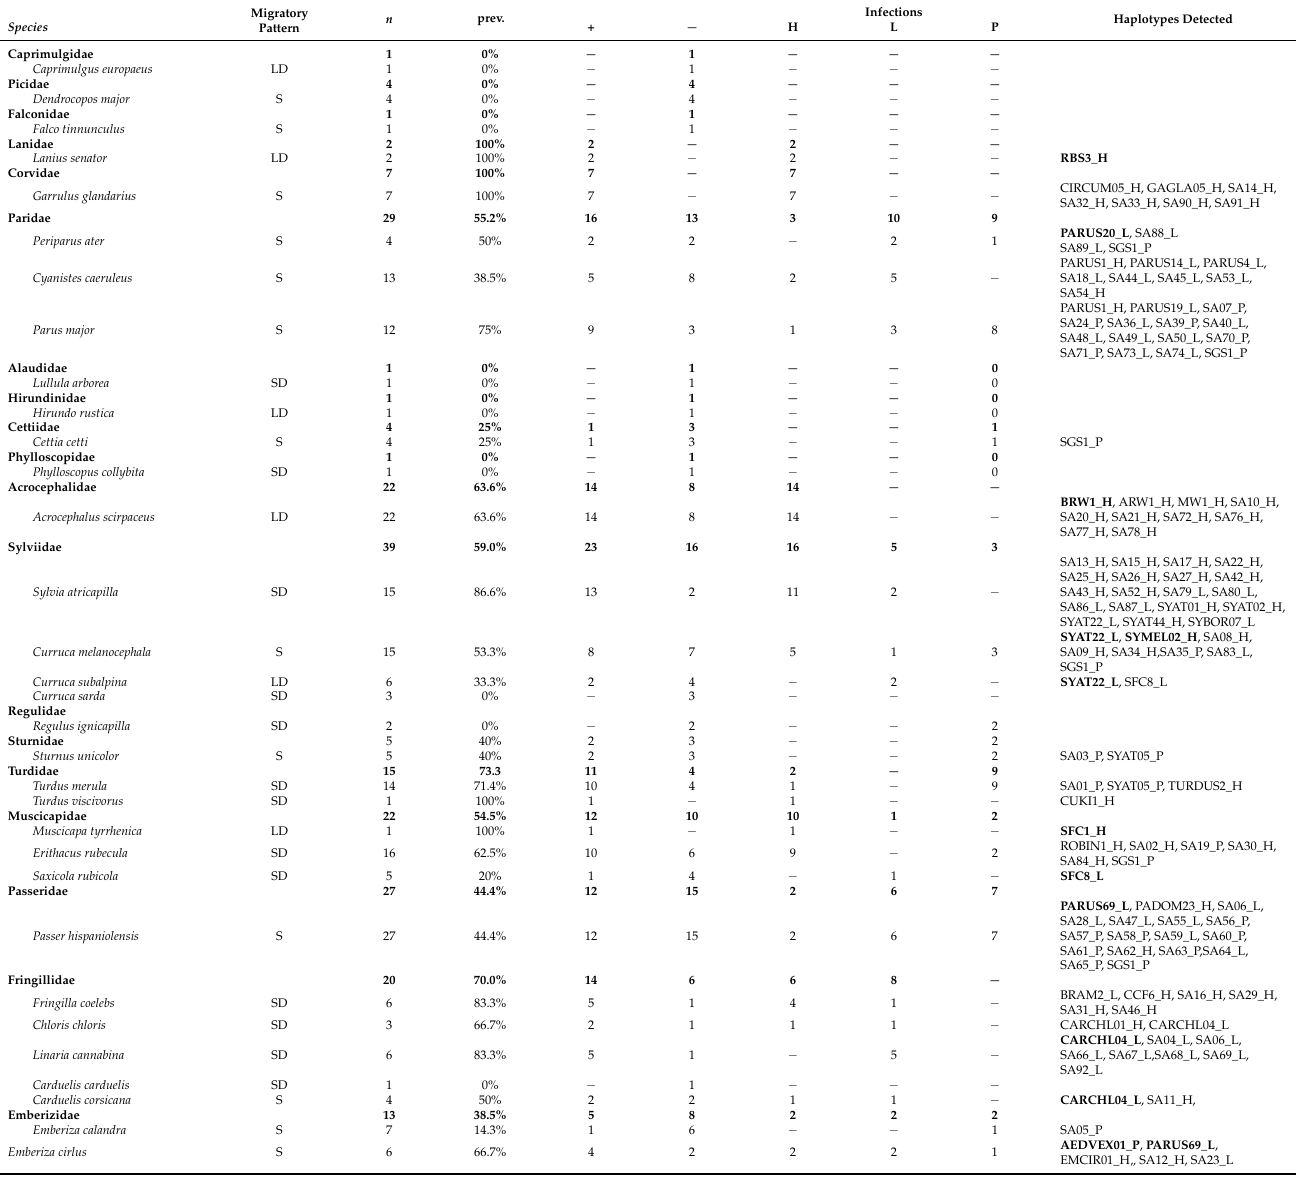
Table 1. List of avian families and species tested for infection by haemosporidians, along with migratory patterns (S = Sedentary; SD = Short-distance migrant; LD = Long-distance migrant); number of sampled individuals ( n ); haemo- sporidian prevalence (prev.); number of positive (+) and negative ( − ) individuals for haemosporidian infection; number of infection relative to Haemoproteus (H), Leucocytozoon (L) Plasmodium (P) haplotypes; and list of haemosporidian haplotypes detected. SA precedes novel Sardinian haplotypes, followed by a unique number, and a designation of which parasite lineage is represented (e.g., SA14_H is the 14th novel lineage we identified, representing Haemoproteus ). Haplotypes in bold highlight new host-parasite associations for known MalAvi